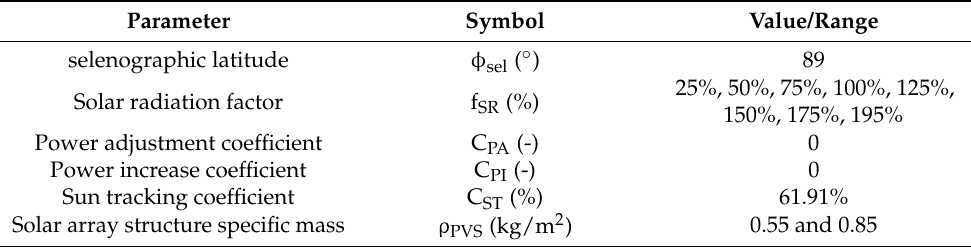
Table 13. Parameters for the Solar radiation factor